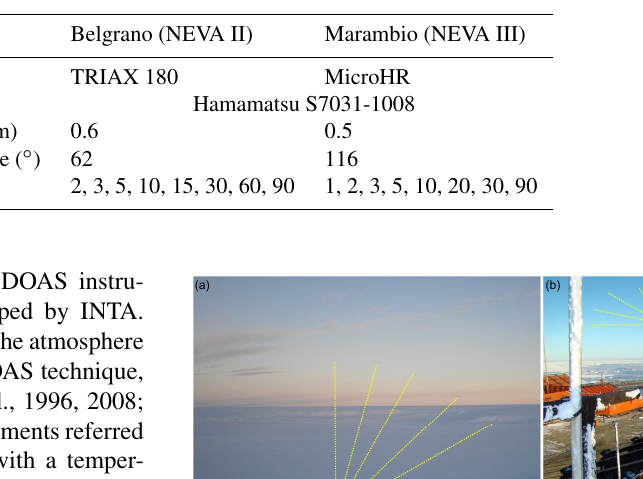
Table 2. Details of the MAX-DOAS instruments installed in Antarctica. The NEVA II instrument is located at the Belgrano research station while the NEVA III instrument is placed at Marambio.